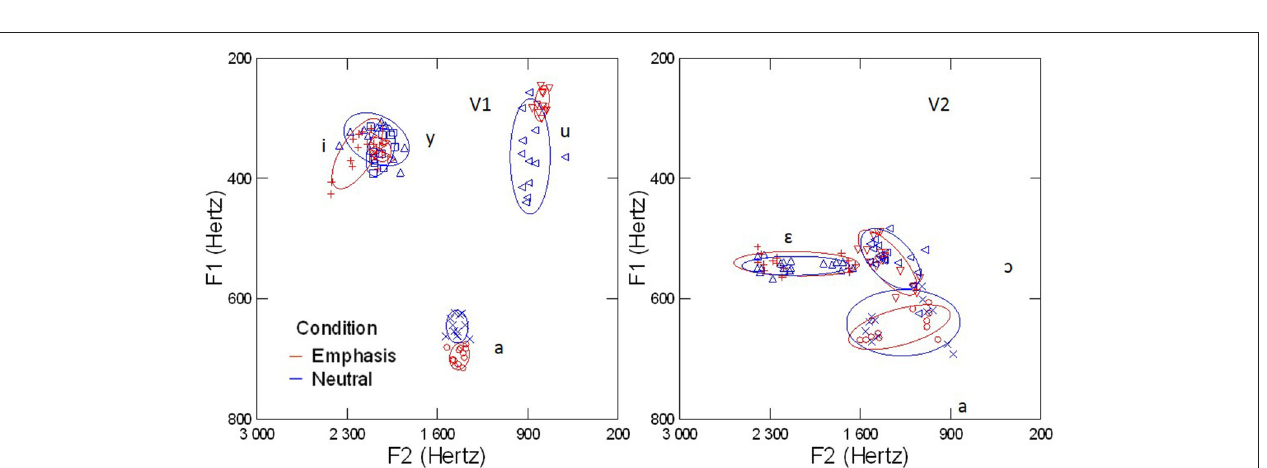
part of the speaker’s face during the production of the